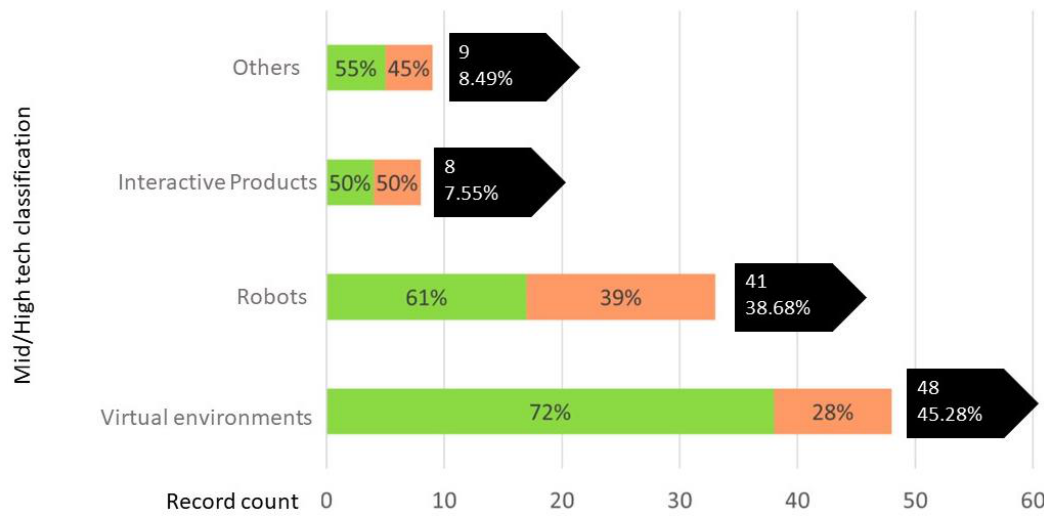
Figure 5. Mid/high tech product classification for